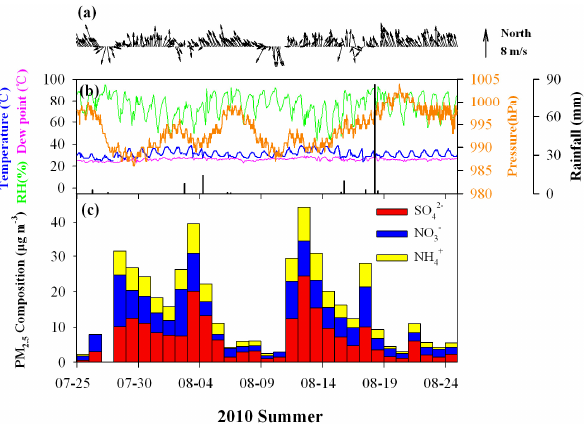
Fig. 5. Same as Fig. 4 but for the summer of Figure 5. Same as Figure 4 but for the summer of 2010.